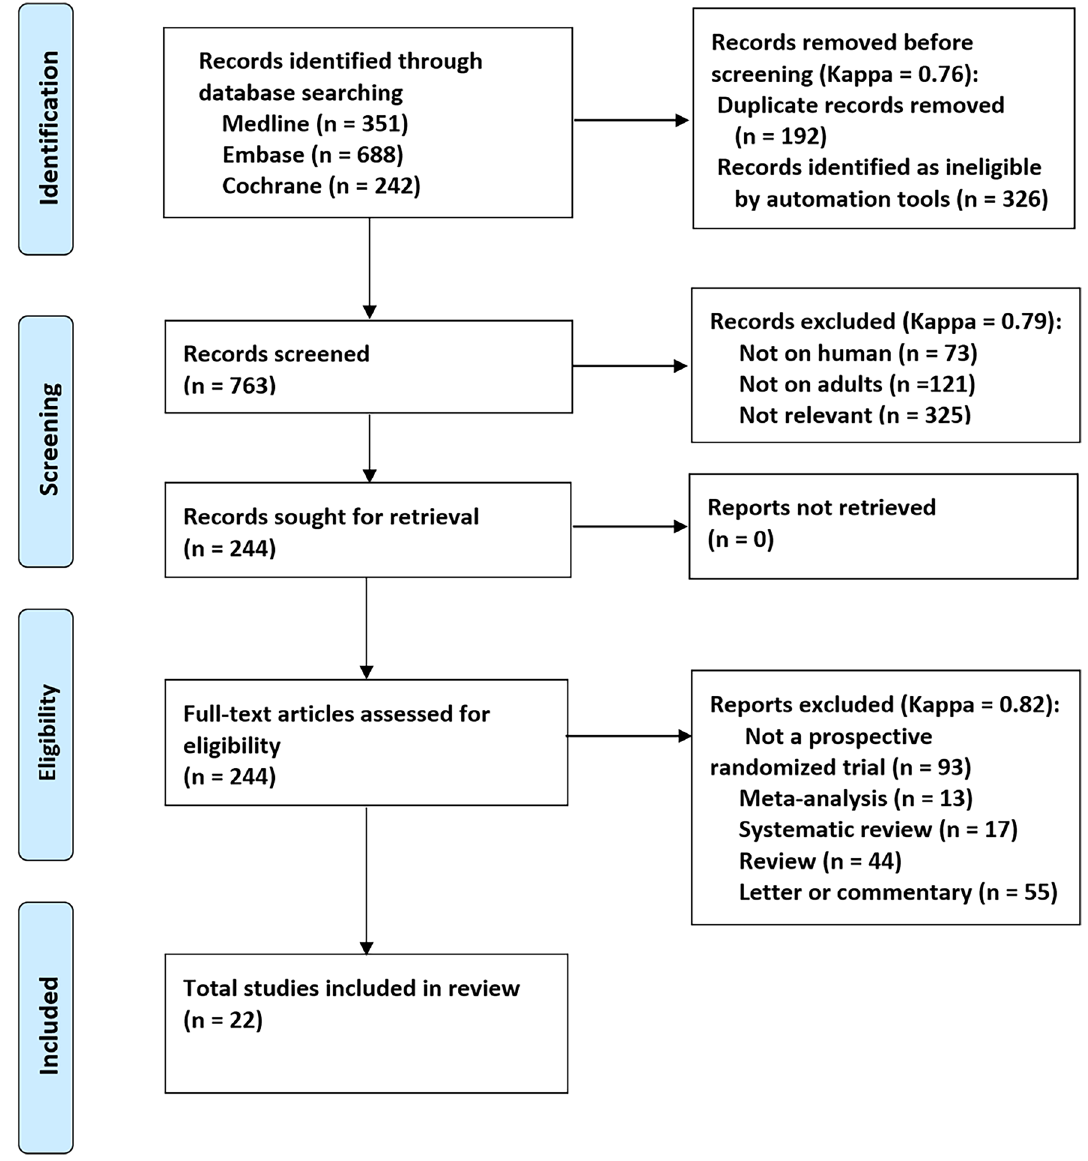
Figure 1. PRISMA (Preferred reporting times for systematic reviews and meta-analyses) 2020 flow